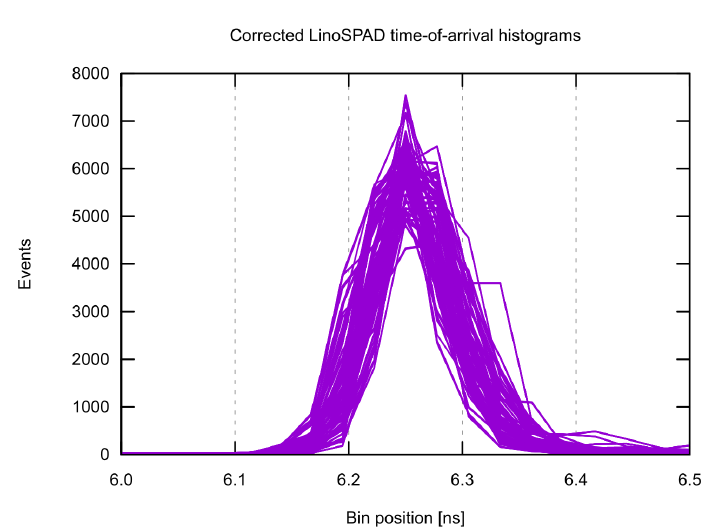
Figure 12. Calibrated FPGA response to a laser pulse shown for each pixel. The mean full-width at half-maximum (FWHM) of these histograms is below 100